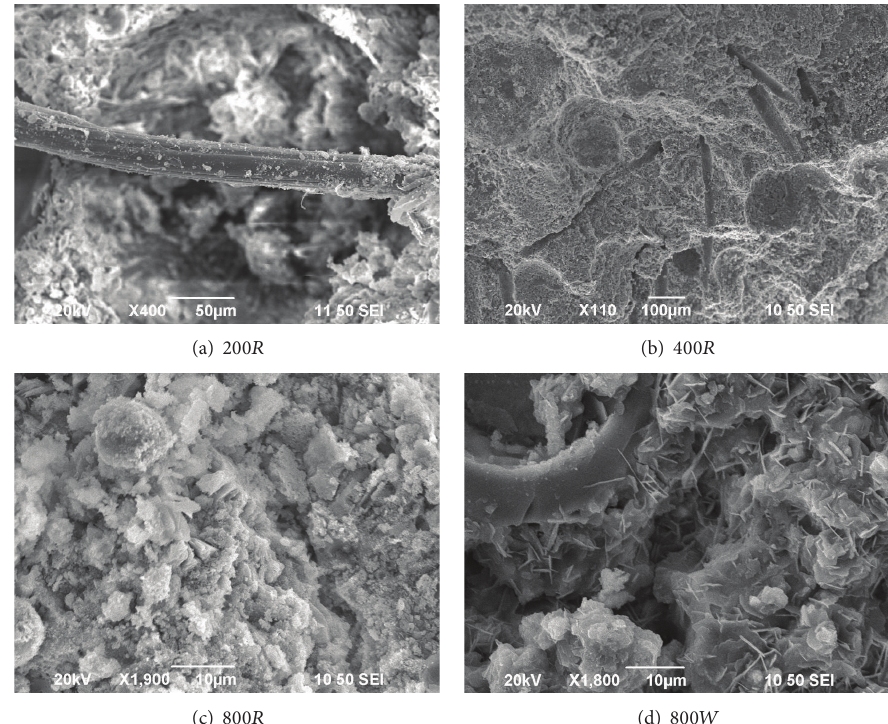
Figure 5: SEM micrograph of ECC specimens subjected to different heating temperatures and cooling regimes: (a) 200 𝑅 ; (b) 400 𝑅 ; (c) 800 𝑅 ; (d) 800 𝑊